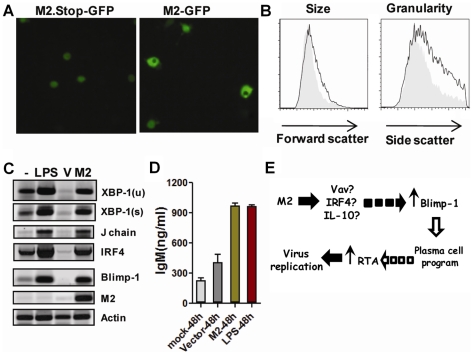
M2 can drive plasma cell differentiation in a B lymphoma cell line.(A) Appearance of plasmacyte morphology following transfection of the murine BCL-1 lymphoma cells with a M2 expression vector. GFP fluorescence in BCL-1 lymphoma cells transfected with either vector control (MSCV-M2.Stop-IRES-GFP) or an M2 expression vector (MSCV-M2-IRES-GFP). GFP expression, driven from an internal ribosome entry site introduced downstream of the M2 open reading frame, was examined at 24 hr post-transfection. (B) M2 expressing BCL-1 cells exhibited increased size and granularity compared to M2.Stop transfected cells, as determined by changes in forward and side light scatter. Filled gray histograms were gated on the GFP expressing cell population in BCL-1 cells transfected with the M2.Stop vector, while the black open histograms were gated on the GFP expressing cell population in BCL-1 cells transfected with the M2 expression vector. (C) RT-PCR analysis of transcripts associated with the plasma cell differentiation program. -, untreated BCL-1 cells; LPS, BCL-1 cells treated with 20 ug/ml LPS and RNA prepared at 24 hr post-treatment; V, BCL-1 cells transfected with a control vector (MSCV-M2.Stop-IRES-GFP); M2, BCL-1 cells transfected with an M2 expression vector (MSCV-M2-IRES-GFP). BCL-1 cells were transfected using a Nucleofector (Amaxa) and RNA prepared at 24 hours post-transfection. (D) Analysis of IgM levels in the tissue culture supernatant of mock treated vs LPS stimulated, or vector control (MSCV-M2.Stop-IRES-GFP) vs M2 expression vector (MSCV-M2-IRES-GFP) transfected BCL-1 cells. As indicated, IgM levels were determined at 48 hours post-treatment. (E) Model of M2 induction of plasma cell differentiation leading to virus reactivation from latency.